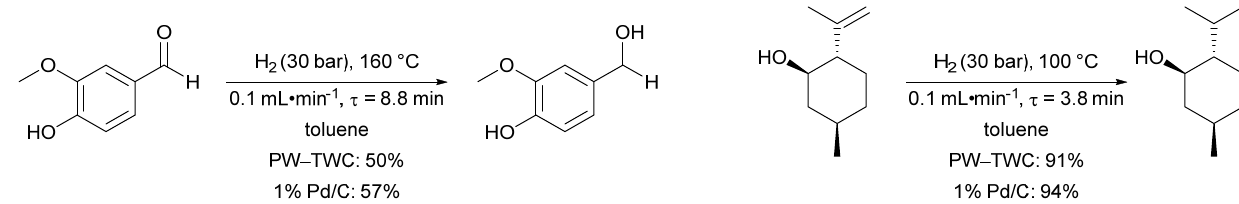
Figure 15. Application of powdered waste three-way catalyst (PW–TWC) materials as in-flow alkene hydrogenation catalysts. Residence time ( τ = catalyst cartridge volume/flow rate), Reproduced with permission from [110].